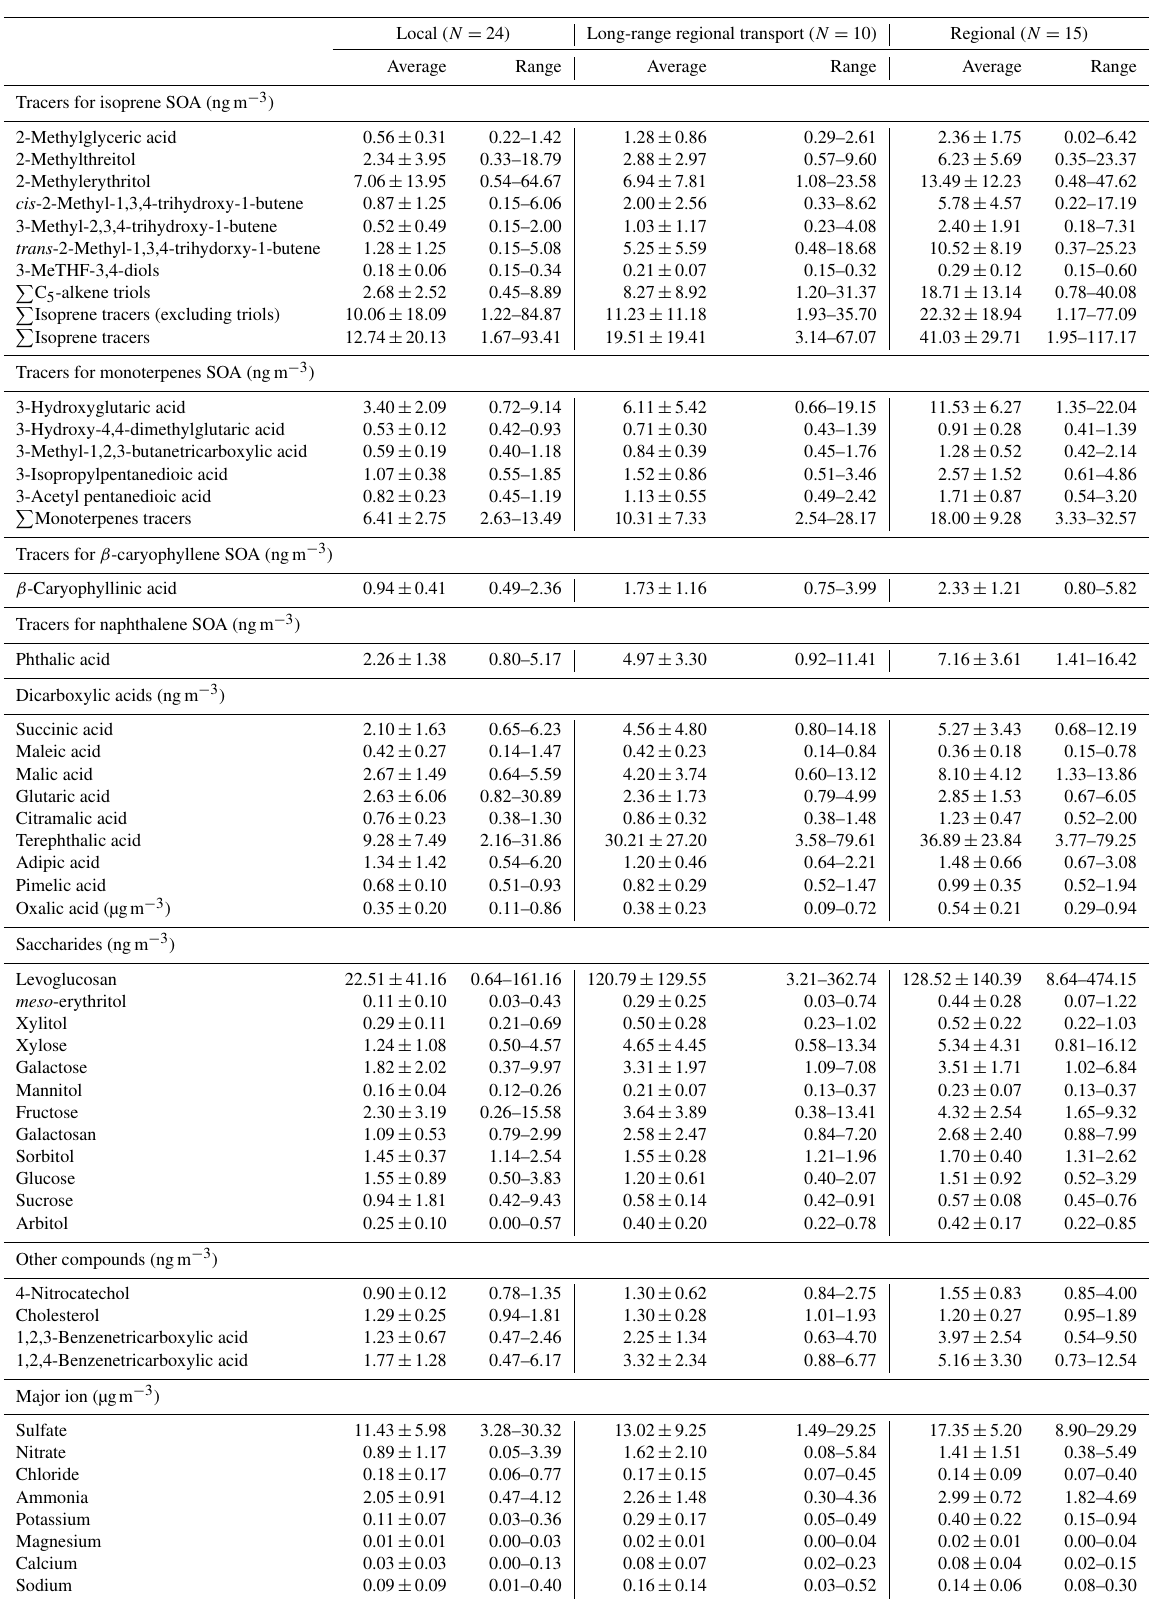
Table 1. Concentrations of 14 SOA tracers, 25 polar organic compounds, and 9 inorganic ions in PM 2 . 5 collected in Hong Kong under three meteorological